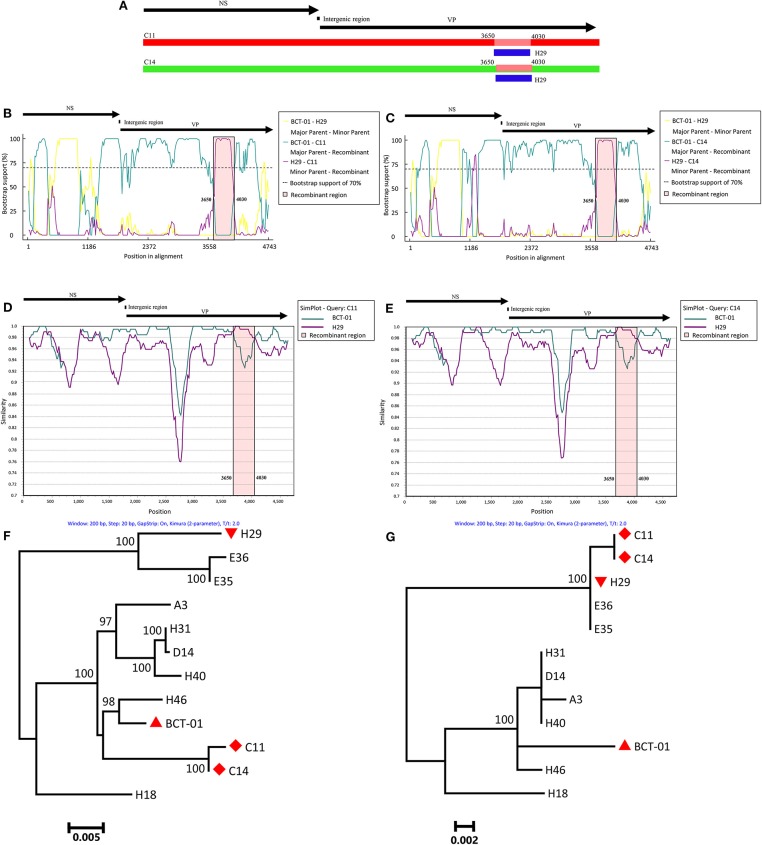
Recombination analysis based on the genomes of C11 and C14. A schematic of the genome organization of EqPV-H is shown above each figure. (A) Schematic; the recombinant genomic region of C11 and C14 is indicated in blue. (B) Bootscanning analysis of C11. (C) Bootscanning analysis of C14. (D) Simplot analysis of C11. (E) Simplot analysis of C14. (F) Phylogenetic analysis of C11 and C14 based on the non-recombinant VP genomic regions. BCT-01, H29, and C11/C14 are indicated by an upright triangle, an upside-down triangle, and a diamond, respectively. (G) Phylogenetic analysis of C11 and C14 based on the recombinant VP genomic regions. BCT-01, H29, and C11/C14 are indicated by an upright triangle, an upside-down triangle, and a diamond, respectively.